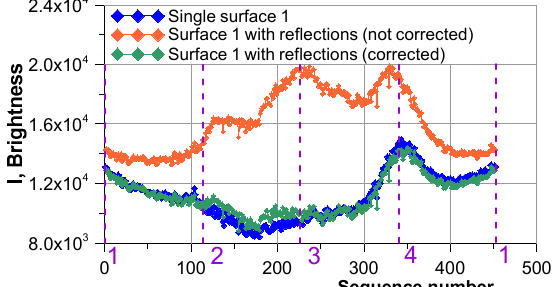
Fig. 5 . Brightness profiles in corrected and initial brightness maps on the 3-D model .